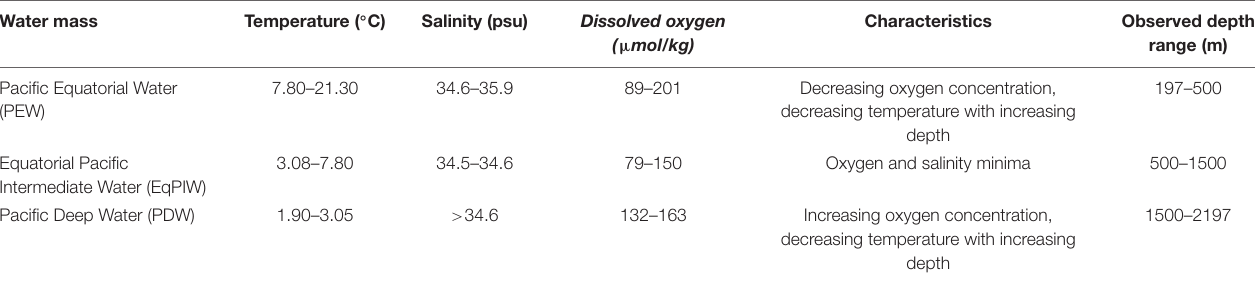
Characteristics Observed depth ( µ mol/kg) range (m) Decreasing oxygen concentration, decreasing temperature with increasing